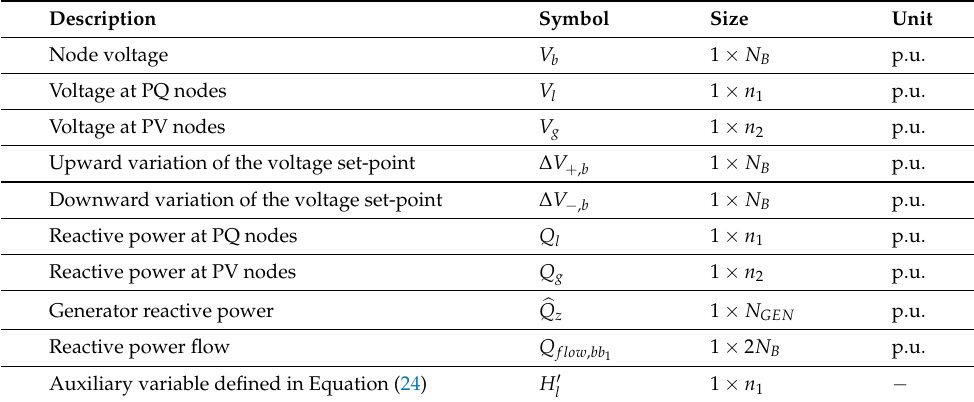
Table 4. Variables for the optimal Volt/Var control